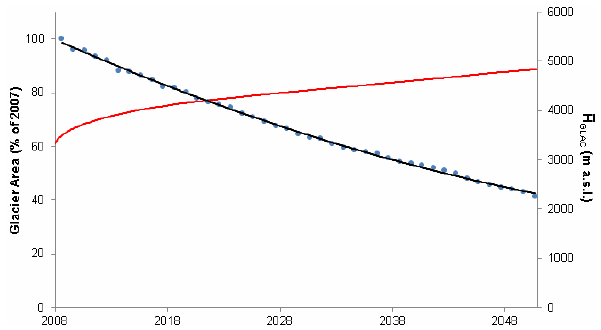
Figure 7. Relative change in glacier area aggregated for all glaciers at the beginning of 3 Fig. 7. Relative change in glacier area aggregated for all glaciers at October for each projected year (blue dots), fitted area depletion curve (black line), and basin 4 the beginning of October for each projected year (blue dots), fitted scale median elevation of the glacierized part of the basins ( GLAC H ) (red line). In this figure 5 area depletion curve (black line), and basin scale median elevation of the glacierized part of the basins ( H GLAC ) (red line). In this fig- the glacier area change, fitted area depletion curve and median elevation of the glacierized 6 ure the glacier area change, fitted area depletion curve and median part of the basins are for the CMIP5 average projection ( ∆ T Q50, ∆ P Q50), for the Amu and 7 elevation of the glacierized part of the basins are for the CMIP5 av- Syr Darya basins combined. 8 erage projection ( 1T Q50, 1P Q50), for the Amu and Syr Darya basins